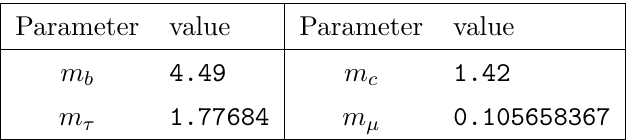
Table 5. Inputs to SMWidth in the (cid:11) ( m Z ) scheme, with M BW note 66. The resulting value of the Fermi constant is G ( G (cid:22) ) (cid:22) = 1 : 19875 (cid:1) 10 (cid:0) 5 .